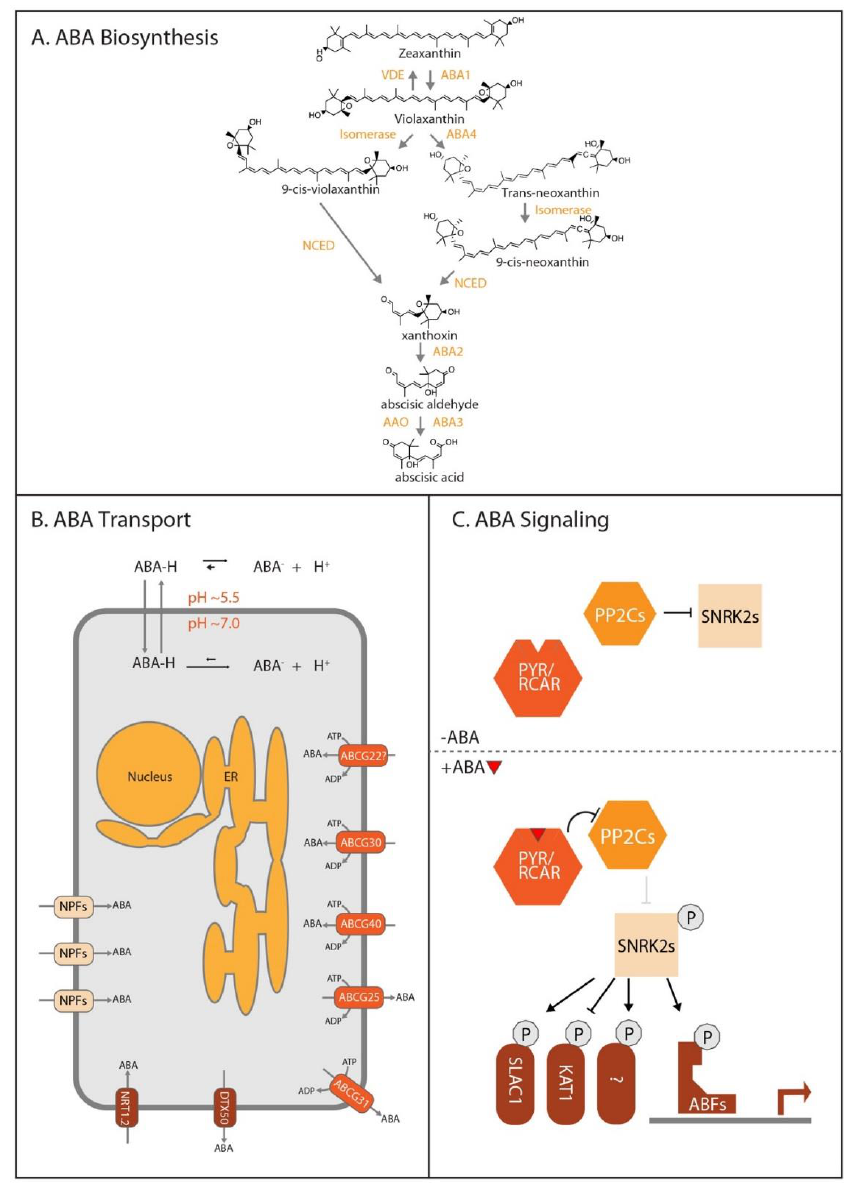
Figure 2. ABA biosynthesis, transport, and signaling. ( A ) ABA biosynthesis. ABA biosynthesis begins with isoprenoids derived from the plastidic methyl- D -erythritol-4-phosphate (MEP) pathway, ultimately leading to the carotenoid zeaxanthin. Zeaxanthin then feeds into the ABA biosynthetic pathway. ( B ) ABA transport. Direction of ABA transport for each of the transporters is indicated by the arrow through the transporter. ABCG22 is listed with a question mark due to it currently not being directly shown to transport ABA but was included due to evidence suggesting that it is involved in ABA transport. Similarly, multiple NRT1/PTR (NPF) family transporters are simply designated as “NPFs?” due to their current standing as possibly involved, but no direct evidence with the exception of NRT1.2 (also known as NPF4.6) has been provided for their involvement in ABA transport. ( C ) ABA signaling. In the absence of ABA (top), the PP2C protein phosphatases interact with and represses the SnRK2 kinases through dephosphorylation. However, in the presence of ABA (bottom), PYR/PYL/RCAR ABA receptors inhibit the PP2Cs, relieving SnRK2 kinases from repression. This leads to SnRK2 phosphorylation and activation, allowing SnRK2s to phosphorylate downstream targets such as the ABRE-binding factors (ABFs) transcription factors.